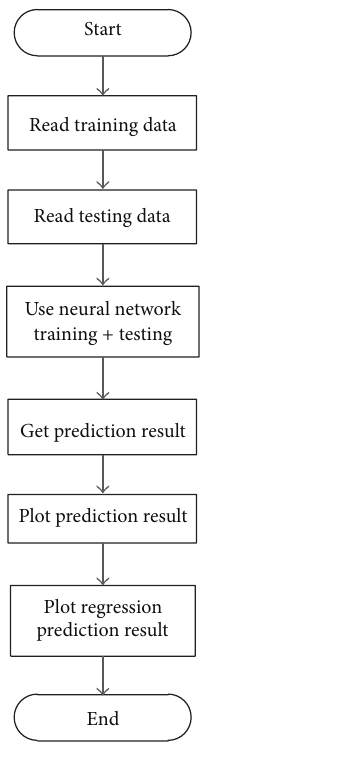
Figure 3: Flowchart of FFBP method.